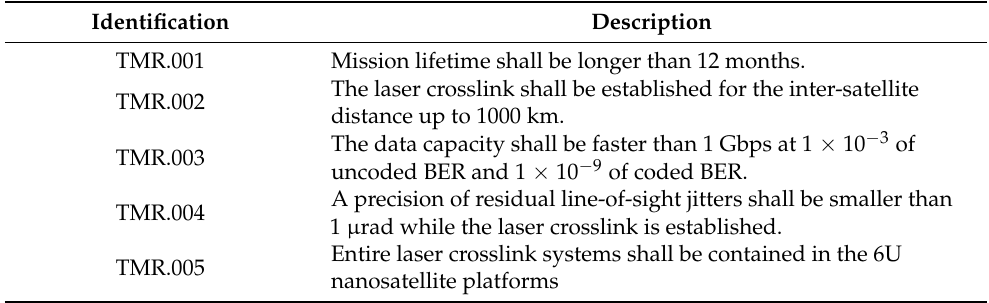
Table 1. Top-level project requirements and constraints.